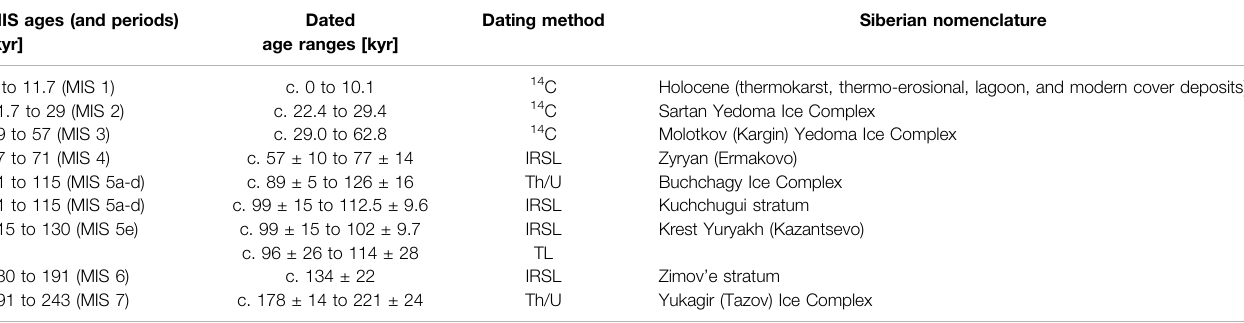
TABLE 1 | The regional Quaternary stratigraphic schemes and the corresponding Marine Isotope Stage (MIS; Lisiecki and Raymo, 2005) used in this work according to Andreev et al. (2004, 2009), Wetterich et al. (2019, 2021) and Zimmermann et al. (2017) and references cited therein. MIS ages (and periods)